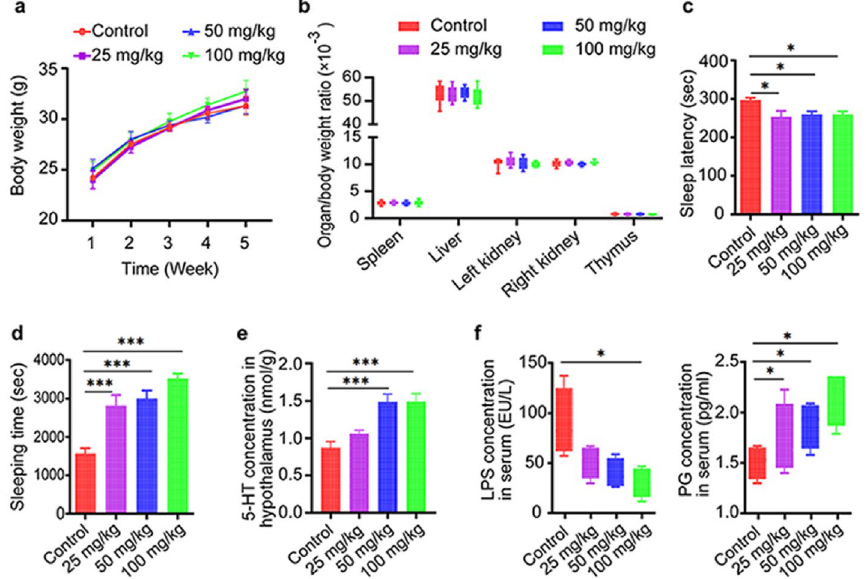
Figure 1. Gavage administration of GLAA promoted sleep in mice with pentobarbital-induced hypnosis. ( a ) GLAA did not affect the weight of mice. ( b ) GLAA did not alter the organ/body weight ratio of the spleen, liver, kidney or thymus. ( c ) GLAA promoted sleep by shortening sleep latency. ( d ) GLAA prolonged sleeping time. ( e ) GLAA increased the concentration of 5-HT in the hypothalamus (n = 4–5). ( f ) GLAA reduced the LPS content and raised the PG content in serum. The data are shown as the means ± SEMs; * p < 0.05, ** p < 0.01, *** p < 0.001, and ‘ns’ indicates that the difference is not significant. The data are calculated from 10 samples per group,